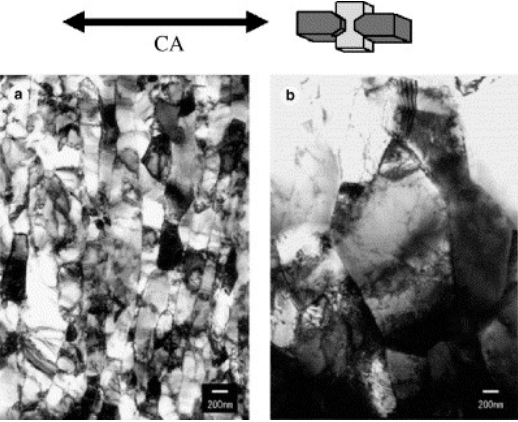
Figure 11. TEM images of the specimen deformed at 823 K at ( a ) 1 s − 1 and ( b ) 0.01 s − 1 [78] .